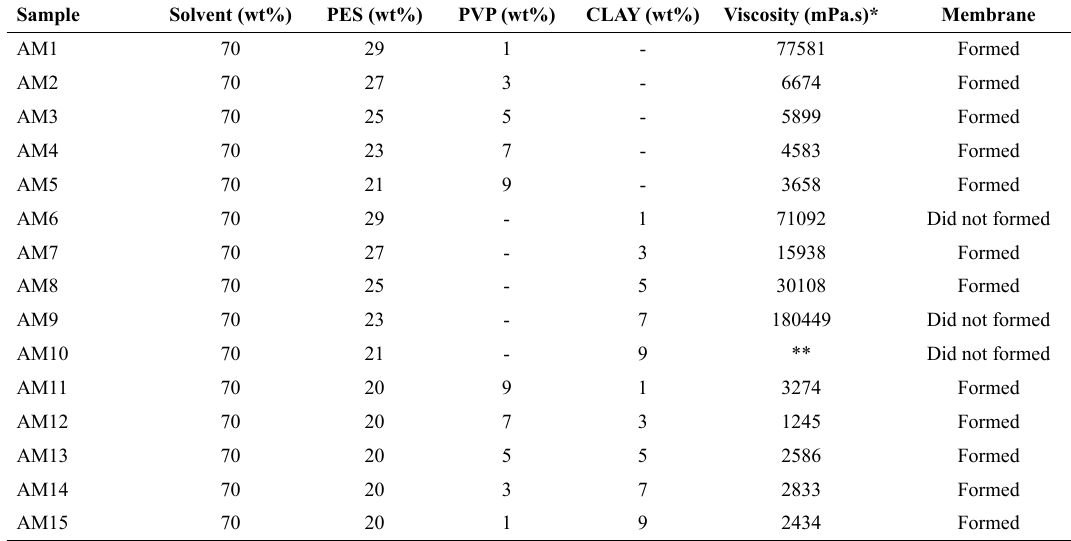
Table 2. Composition and viscosity of the solutions Sample Solvent (wt%) CLAY (wt%) Viscosity